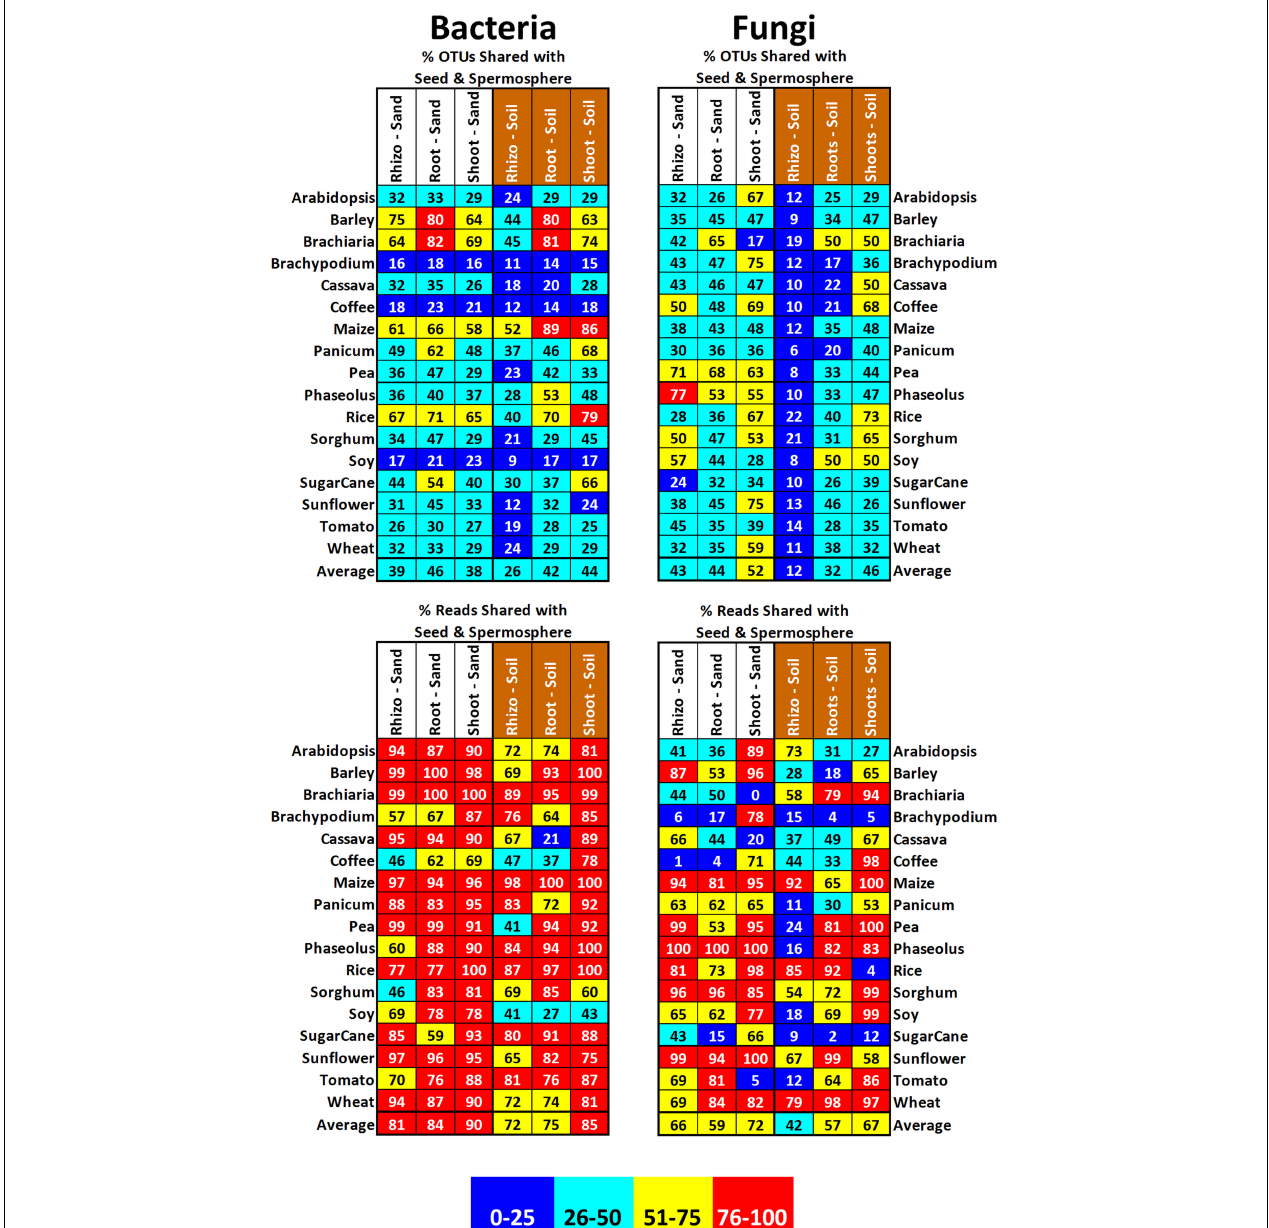
FIGURE 5 | Proportion of OTUs and reads in the shoots, roots, and rhizospheres of different plant species growing either on sterile sand (labeled in white) or field soil (labeled in brown) that were also observed in that species’ corresponding seeds or spermospheres. Cells are shaded to reflect proportion, with 0–25% being blue, 26–50% being green, 51–75% being yellow, and 76–100% being red. An average across all the plant species is shown at the bottom of each